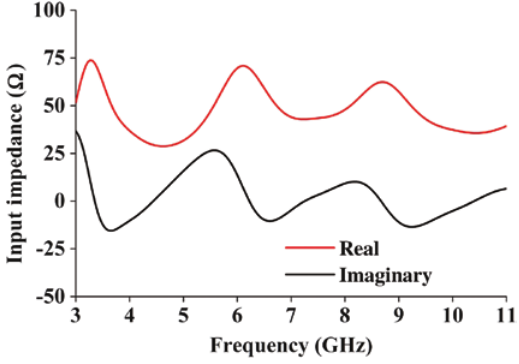
Figure 2: Input impedance of the proposed antenna.